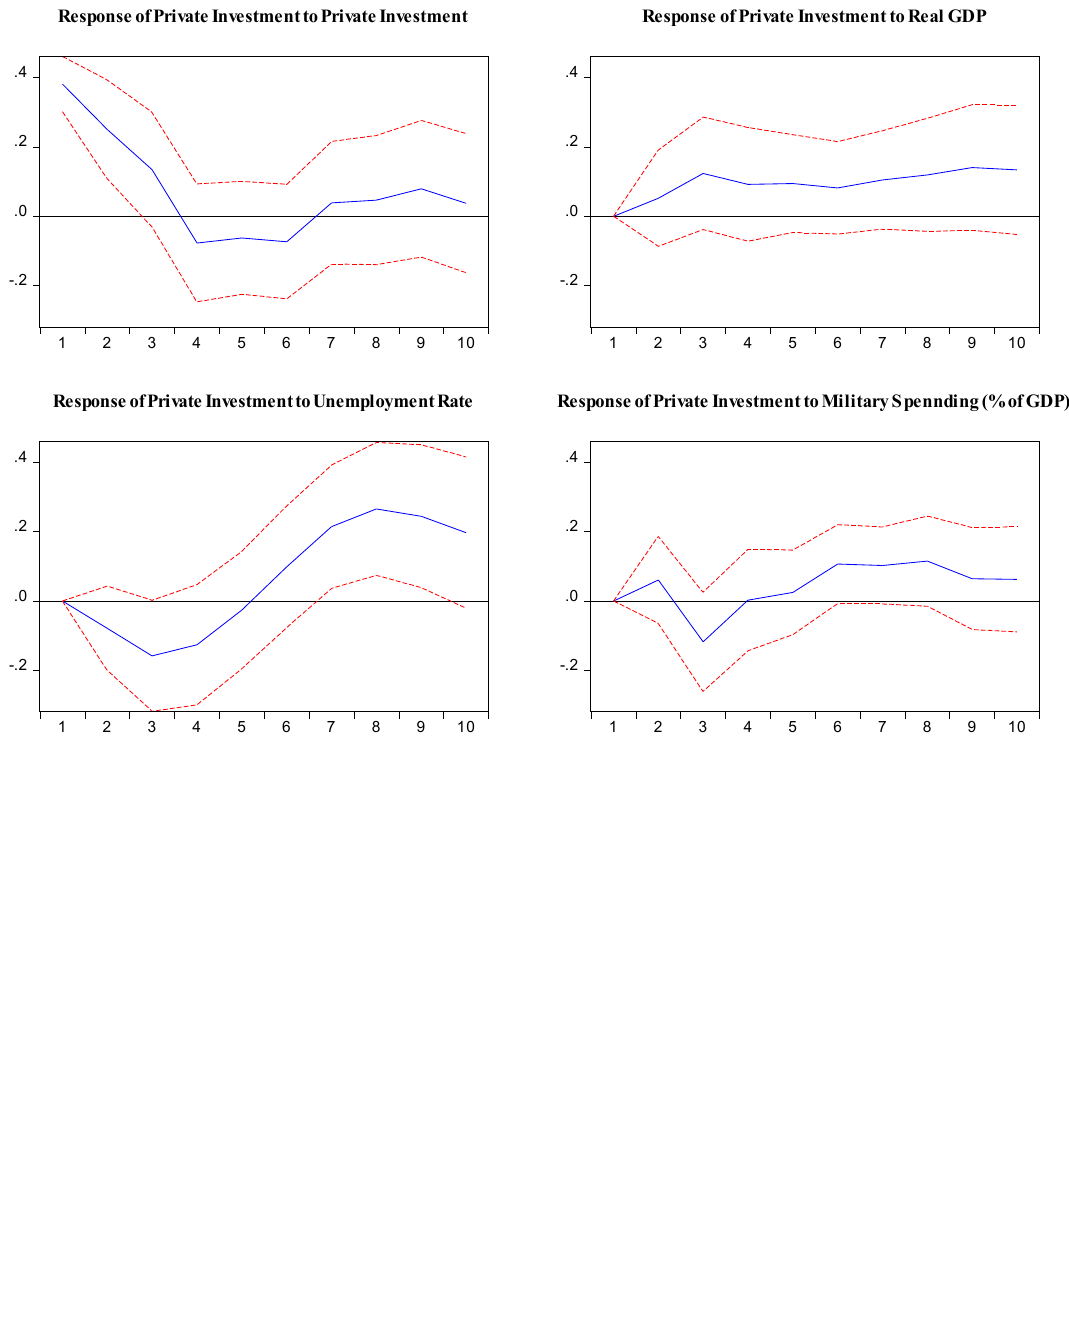
Figure 5: Response of Private Investment to Military Spending (% of GDP) and Other